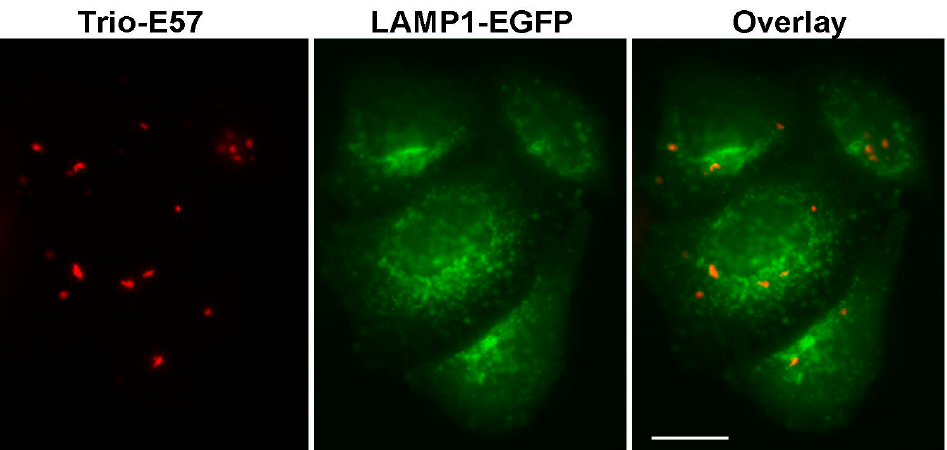
Figure 11. Trio-E57 aggregates and lysosomes. Wide-field fluorescence microscopy of HeLa Kyoto cells coexpressing Trio-E57 and lysosomal marker LAMP1-EGFP in red (left) and green (middle) channels. Right panel—overlay; scale bar, − 20 µm.